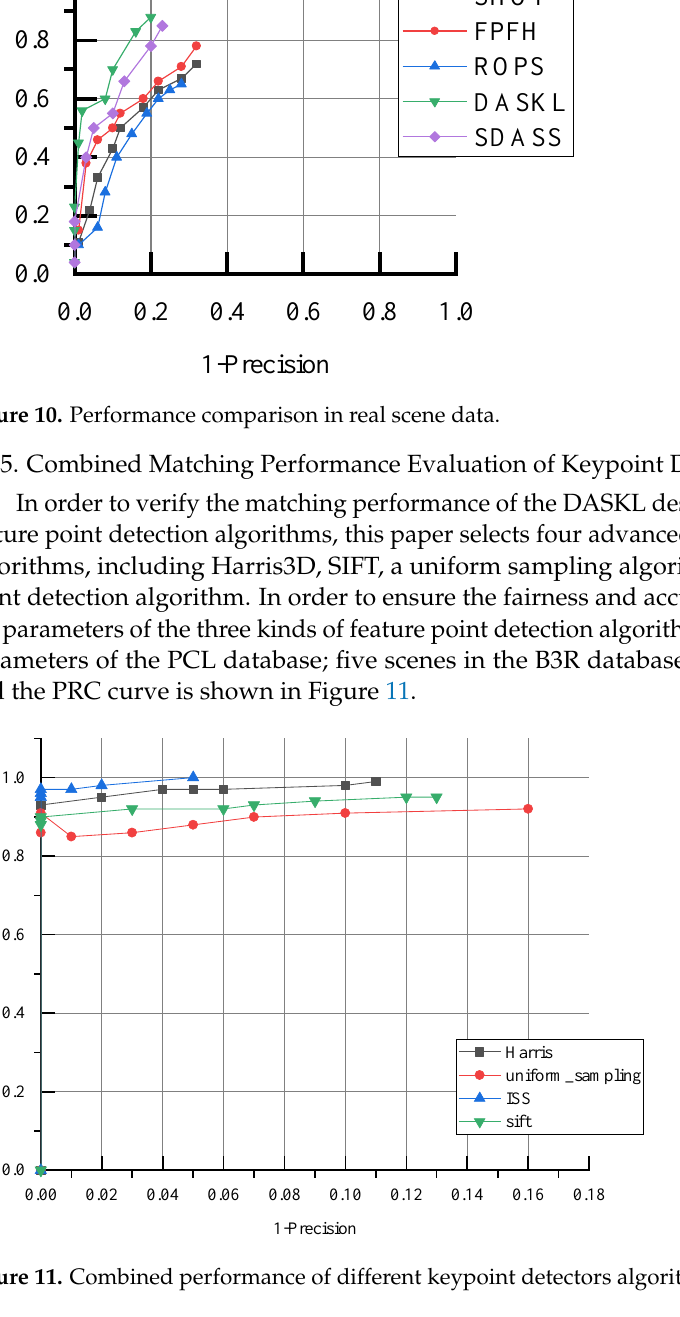
1-Precision SHOT FPFH ROPS DASKL SDASS ( c ) Figure 9. Comparison of matching performance under different occlusion ( a ) Occlusion 60 – 70%. ( b ) Occlusion 70 – 80%. ( c ) Occlusion 80 – 90%. 3.3.4. Matching Performance on Real Scenes Twenty-five scenes in the LIDAR real scenes are randomly selected and matched with the targets to be identified in the database, and the PRC results are shown in Figure 10. Looking at Figure 10, we can see that in the complex ground scene database, and the